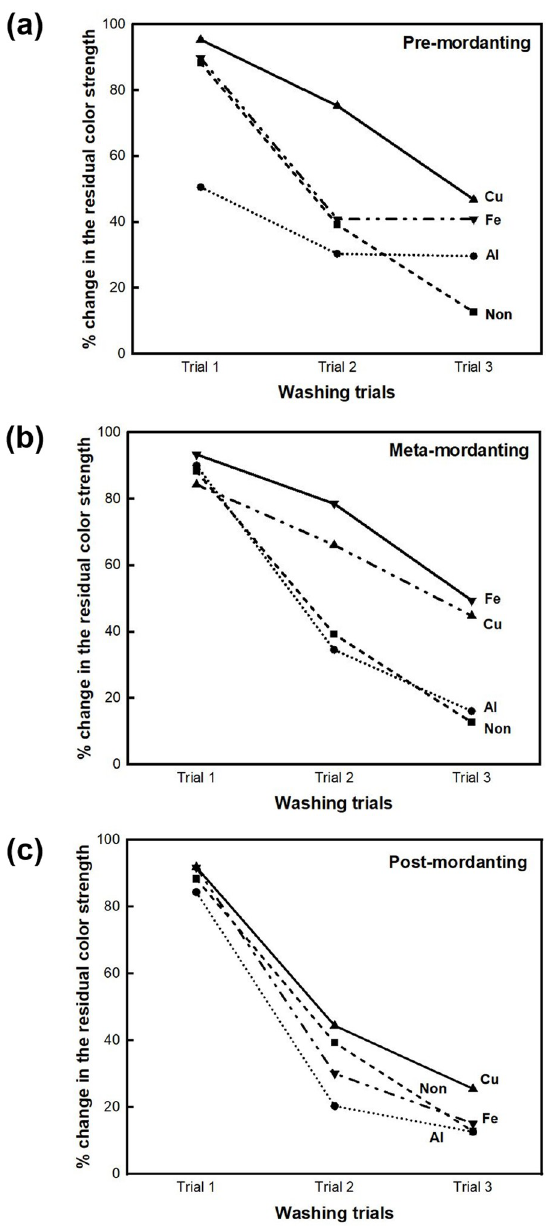
Fig 4. The percent change in the residual color strength of BC-COF bio-leather (a) pre-mordanted with AlK(SO 4 ) 2 , CuSO 4 , and FeSO 4 ; (b) meta-mordanted with AlK(SO 4 ) 2 , CuSO 4 , and FeSO 4 ; (c) post-mordanted with AlK(SO 4 ) 2 , CuSO 4 , and FeSO 4 (Extraction conditions: liquor ratio of 1:10 (w/v), coffee at an amount of 200 wt% BC, 90˚C, 1 h; Dyeing conditions: fabric-to-liquor ratio of 1:10 (w/v), 70˚C, 30 min).